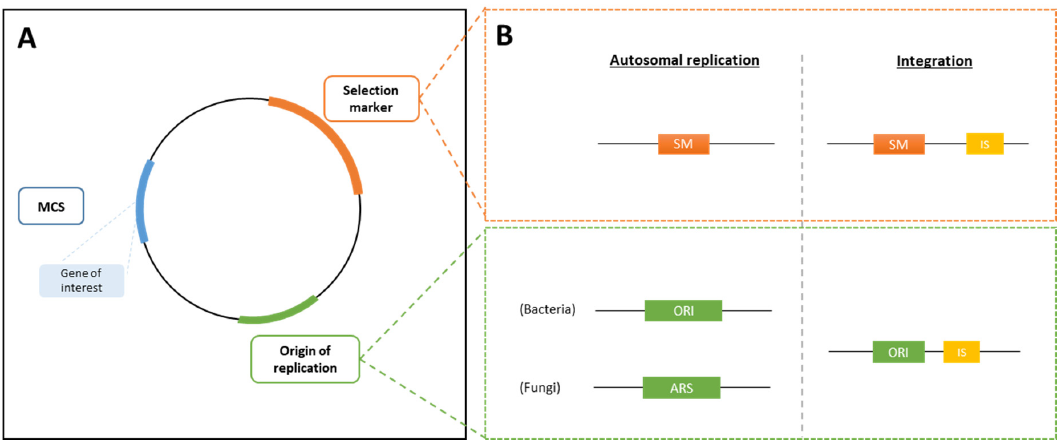
Figure 1. Schematic representation of an expression vector. (A) Expression vectors contain an origin of replication (ORI), followed by the multiple cloning site (MCS) where the gene of interest is integrated and a selection marker (SM). (B) Both an episomal plasmid and integrative plasmid, containing flanked integration sites, can be created. ARS, autonomous replication sequence; IS, integration site.